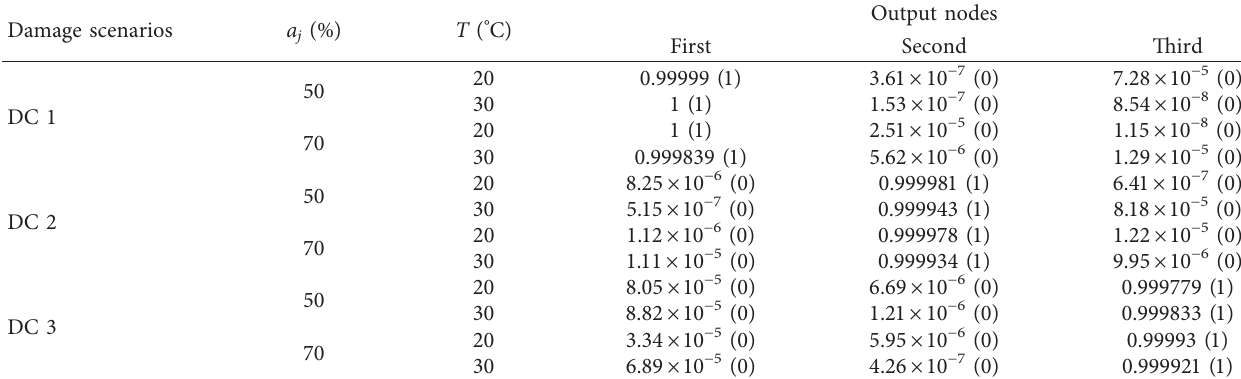
Table 3: The identification results of damage locations when one brace is damaged.